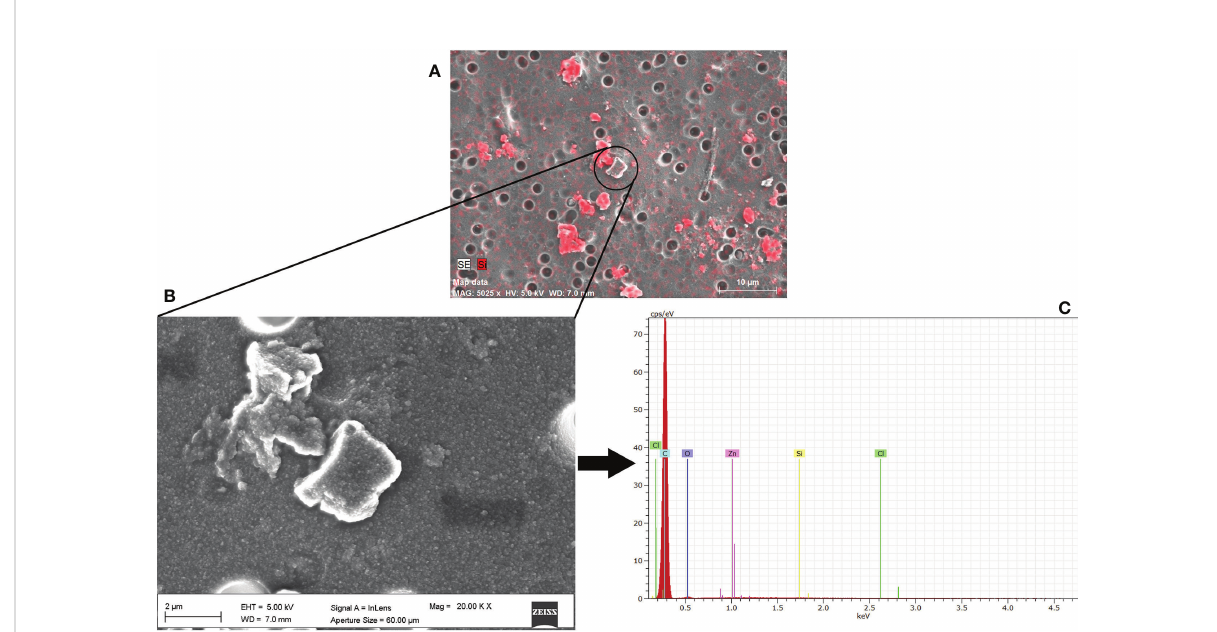
FIGURE 5 Identi fi cation of microplastic particles (2-20 µm) extracted from deep-sea sediments by Scanning Electron Microscopy. (A) Silicon EDX map (mapping Si mineral) used to distinguish sediments from the other inorganic particles, (B) close-up of microplastic particles (C) EDX spectrum con fi rming the large presence of C atoms (the highest peak). Carbon is present in all the investigated plastics and therefore cannot be used for recognizing the different